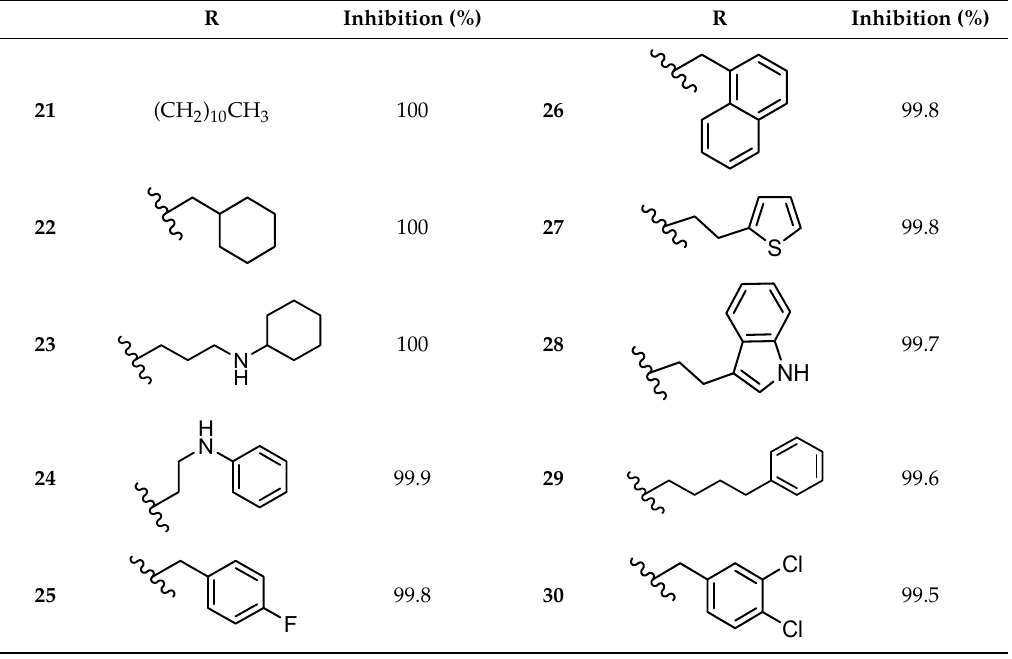
Table 2. Structural details and human cytomegalovirus (HCMV) polymerase inhibition values of compounds 21 – 30 (adapted from [86]).